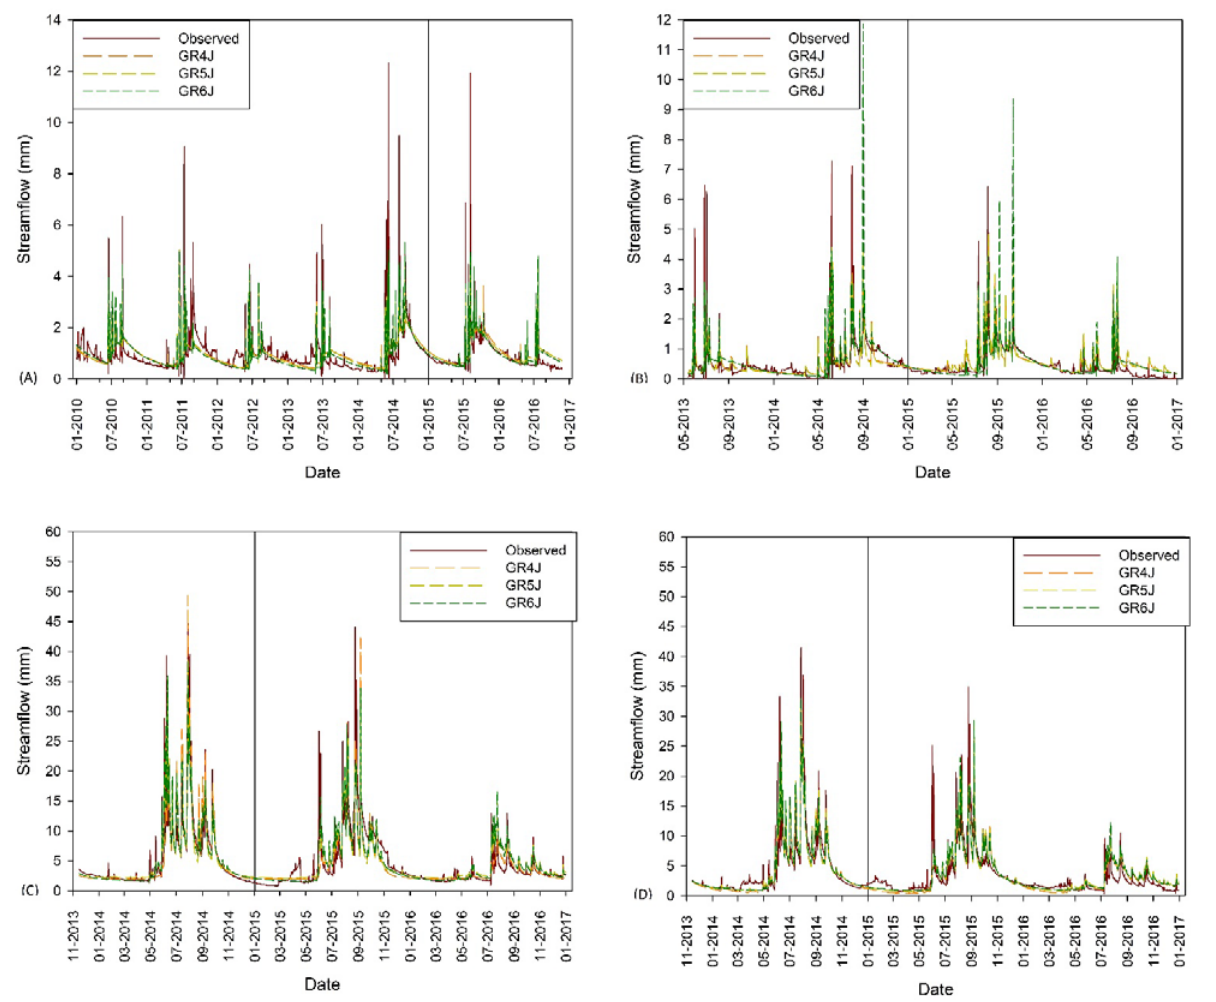
Figure 5. Simulated and observed discharge for ( A ) Q1, ( B ) Q2, (C) BLQ 1 and ( D ) BLQ2 using the GR4J, GR5J and GR6J models for the calibration and validation period. Vertical line represents the end of calibration period and start of the validation period (1 January 2015).